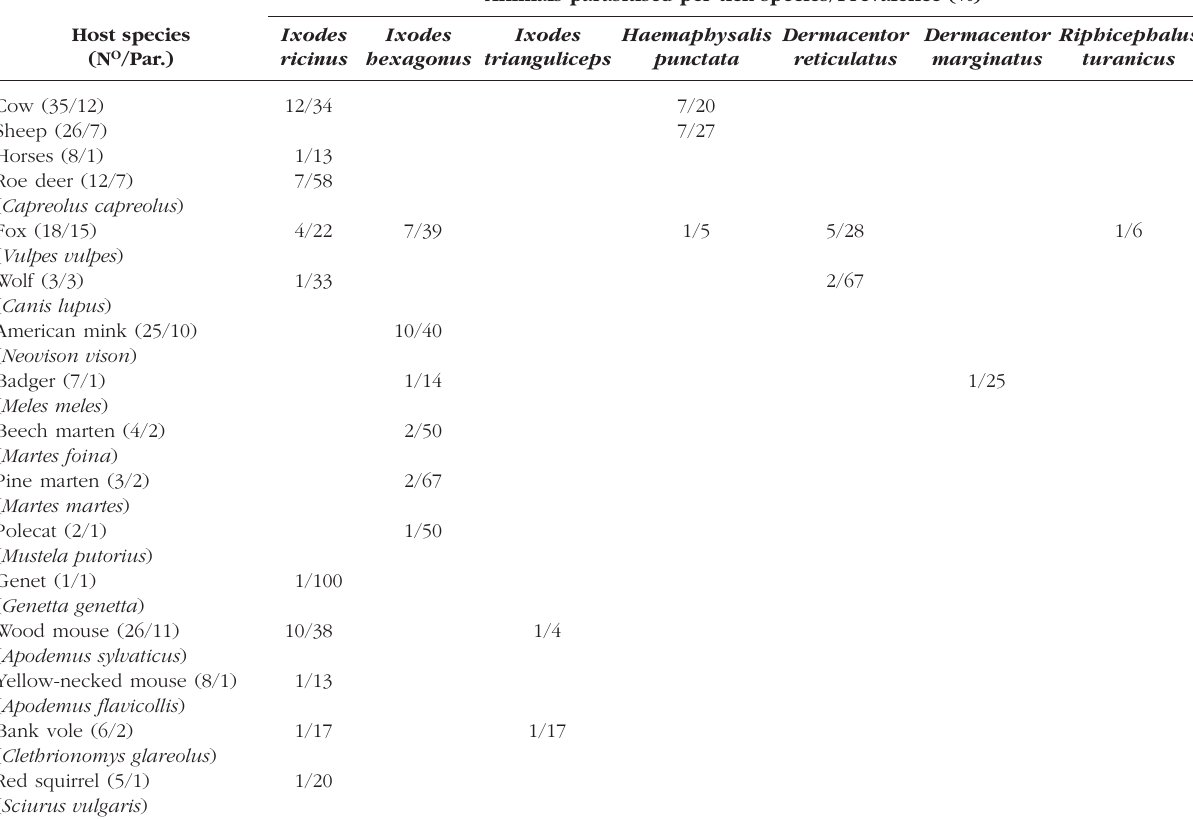
Table II a. – Species of ticks identified on the host